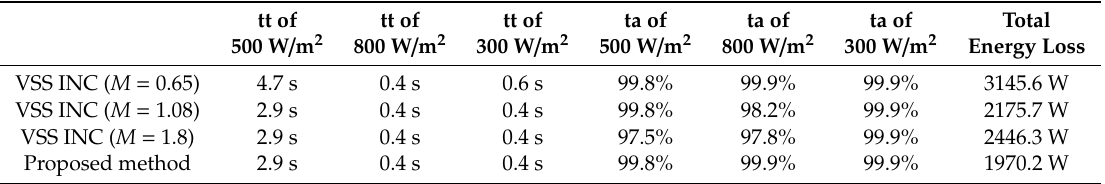
Figure 6. Power tracking curves of different M values. Table 4. Summarized simulated results of different M values. Table 4. Summarized simulated results of di ff erent M values.